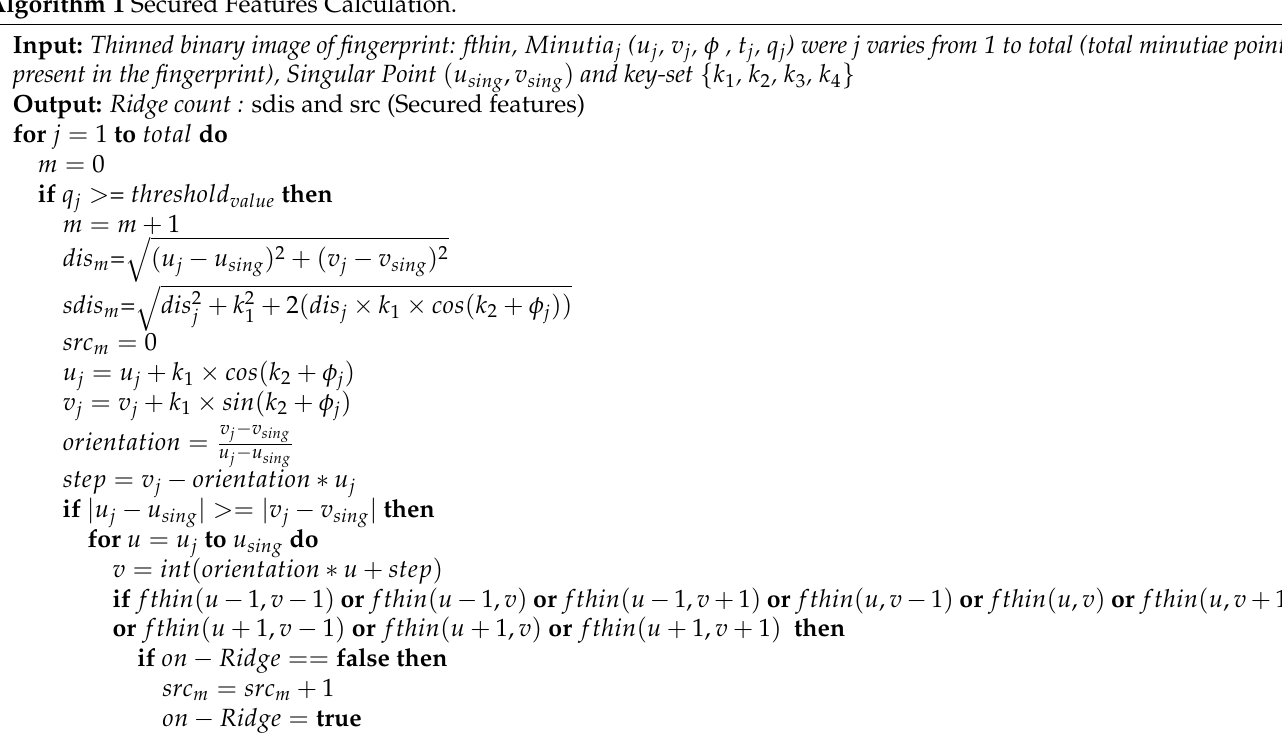
Algorithm 1 Secured Features